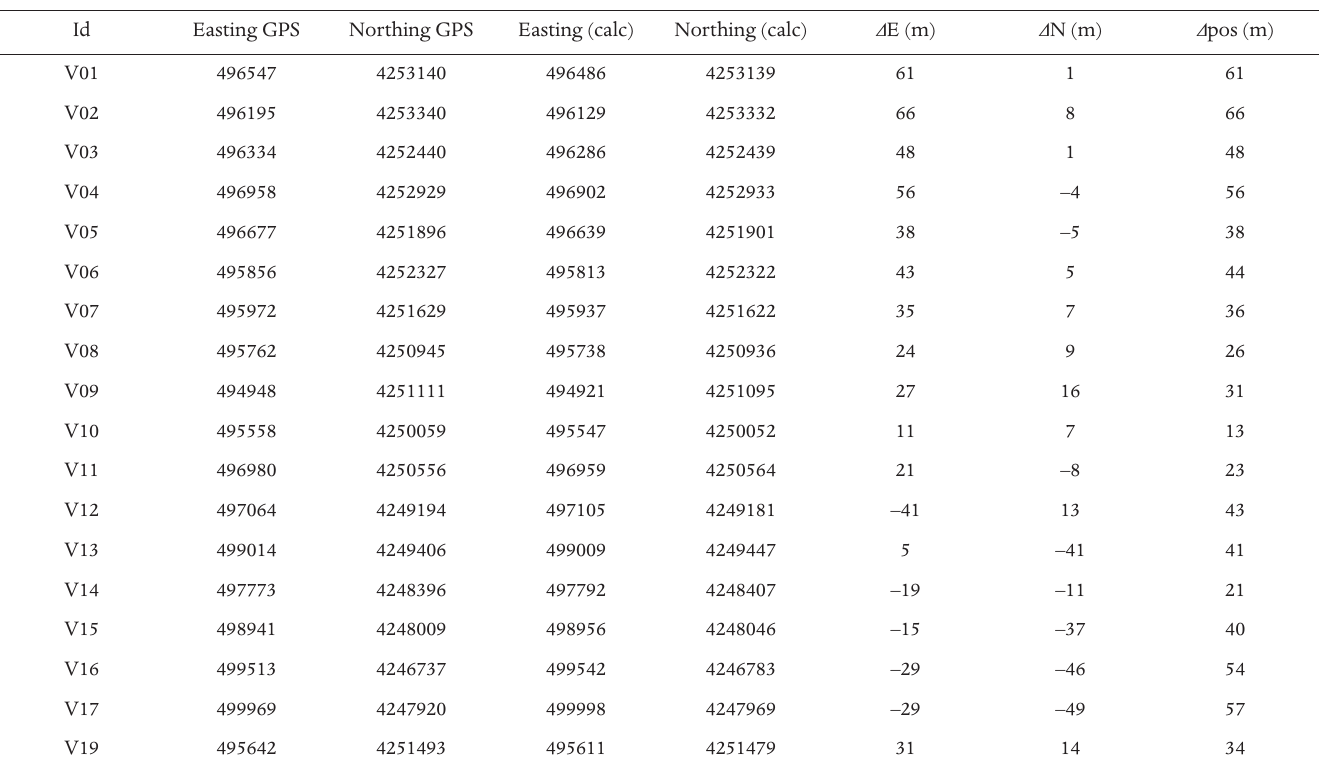
Table 1. Measured GPS points (UTM WGS 1984) acquired during the July 27, 2008, survey. The calculated values (calc) are from the transformation of the original Gauss Boaga coordinates taken from the georeferenced CTR map of Vulcano Island; D E, D N and D pos are the residuals between the measured and calculated Easting, Northing and position,